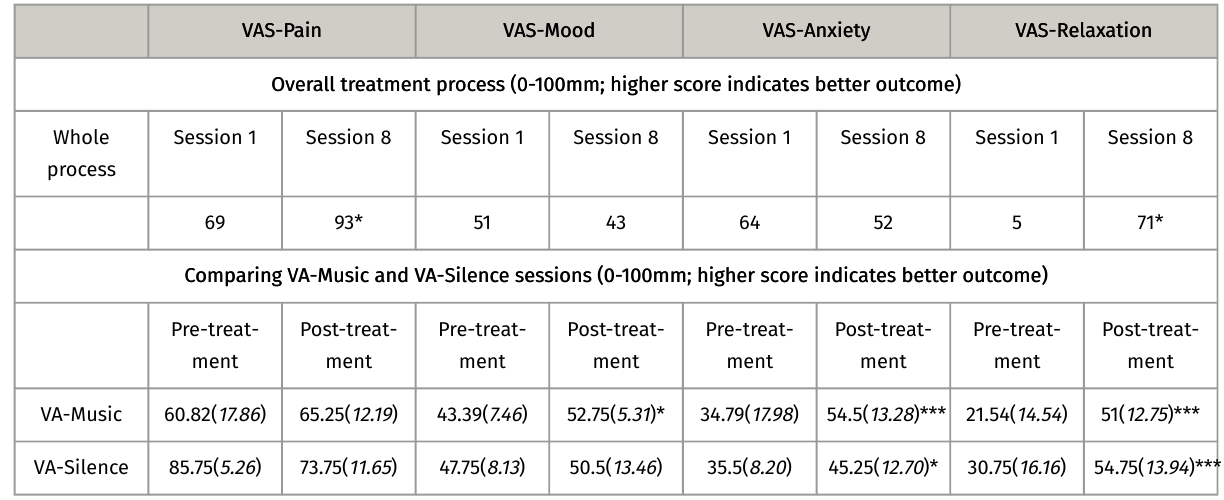
Pre-treatment Session 1 and post-treatment Session 8 scores for all variables showing progression over time, and mean (and stan- dard deviation) of all pre- and post-treatment scores for each variable comparing VA-Music and VA-Silence sessions. Note: All Visual Analogue Scales range from 0-100mm; a higher score represents a more favourable outcome; *Indicates the Mini- mal Clinically Important Difference(MCID); **Indicates moderate change; ***Indicates substantial